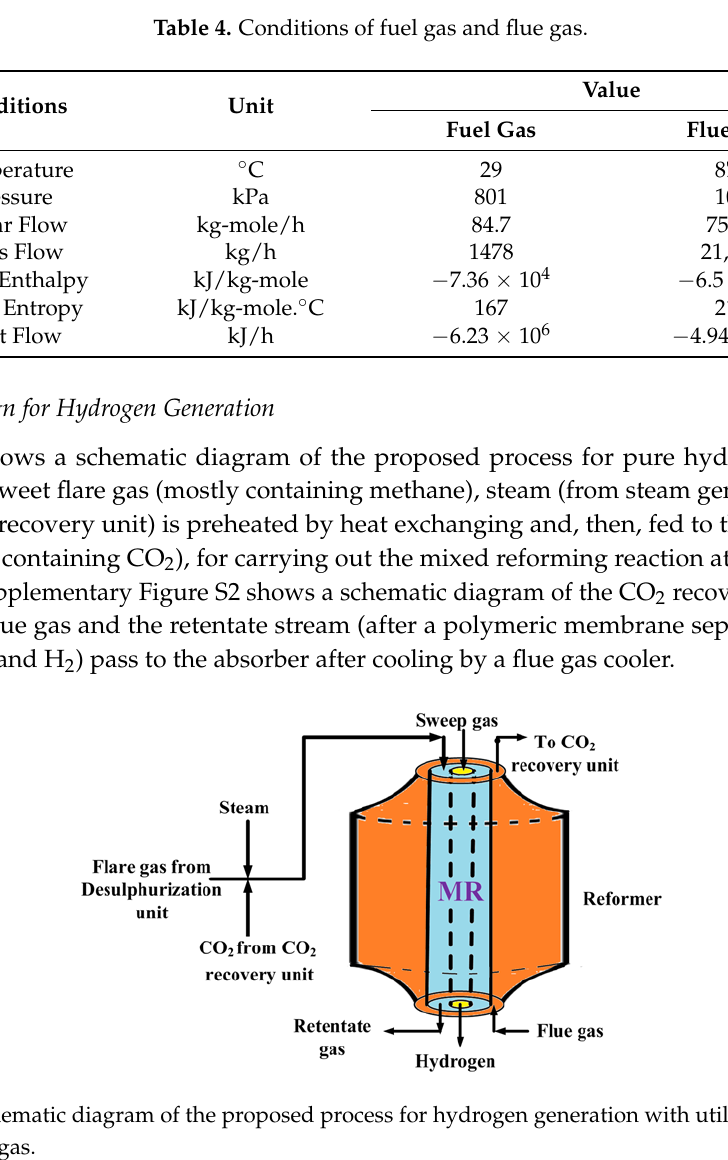
Table 4. Conditions of fuel gas and flue gas.